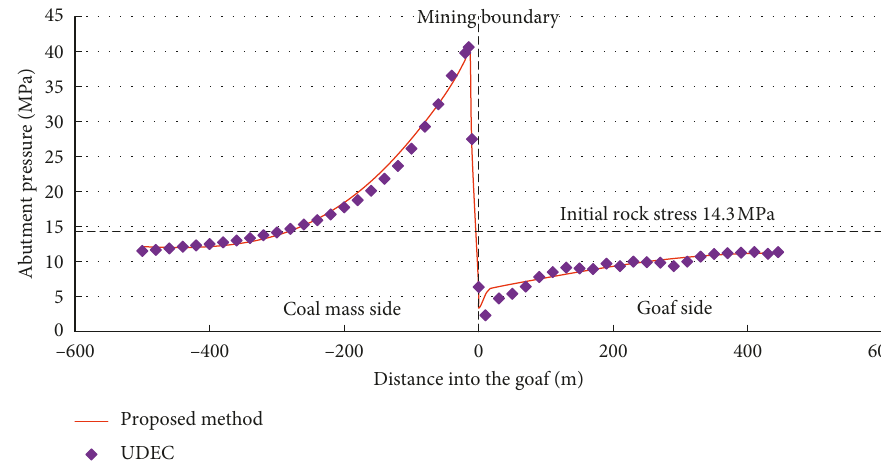
Figure 13: Comparison of stress distributions predicted by UDEC and the proposed